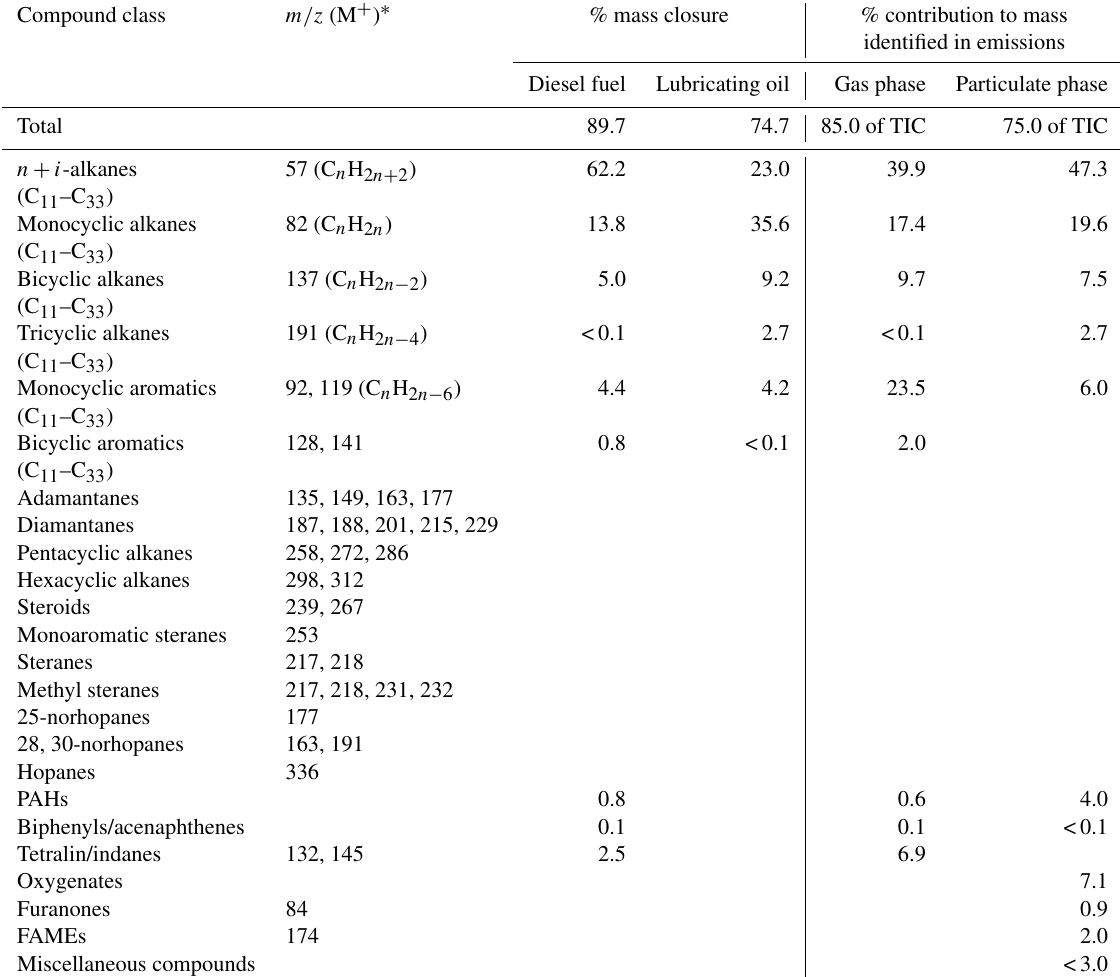
Table 1. Hydrocarbons identified in diesel fuel, lubricating oil and diesel exhaust emissions (gas and particulate phases) with their respective m/z fragment ions and percentage mass